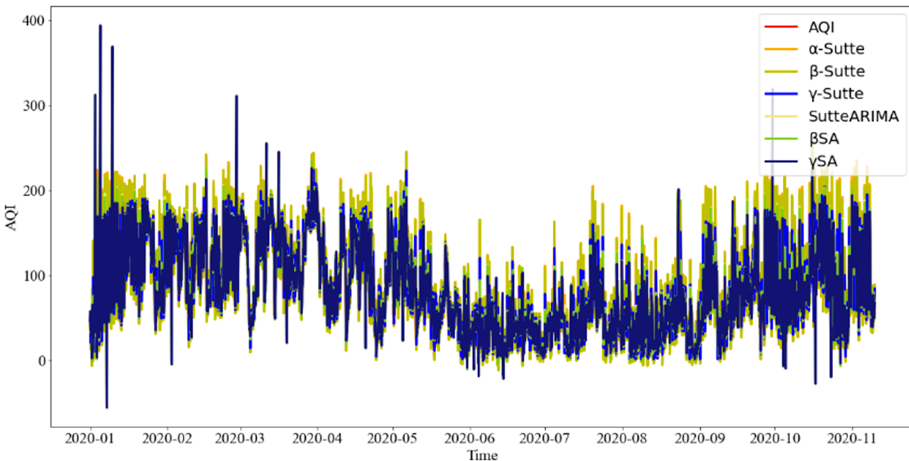
Figure 6. Time series model and ensemble model trend chart of the Vientiane area in 2020 . Table 6. Prediction results of time series model and ensemble model in the Vientiane area.